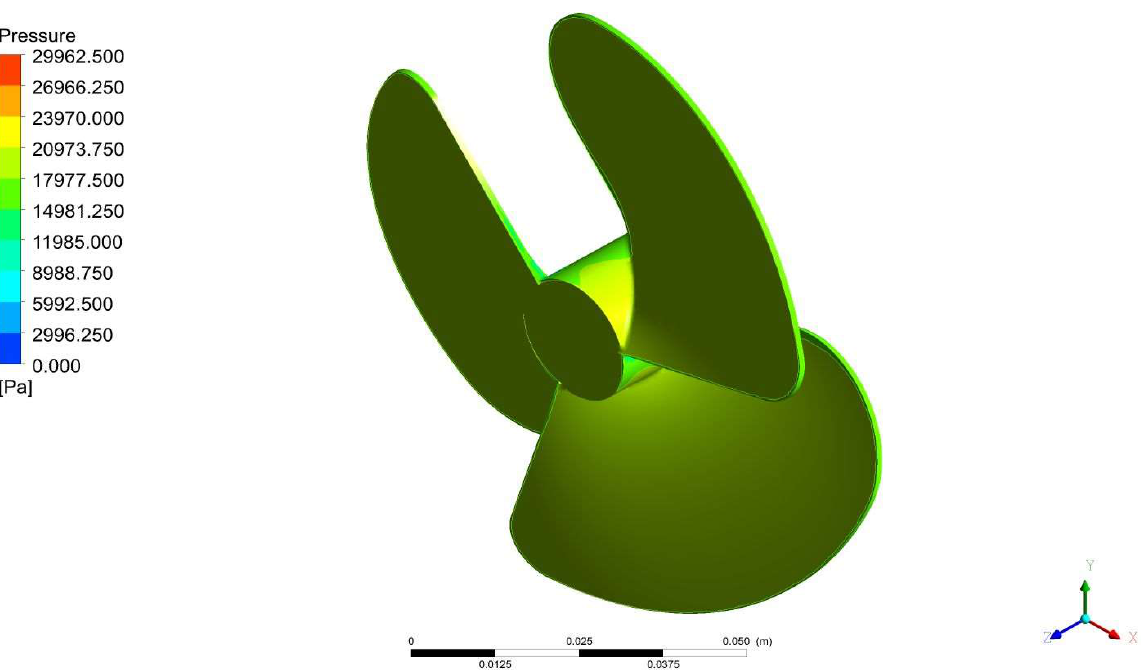
Figure 43. Hydrodynamic pressure variations on Hydro-Rotor.